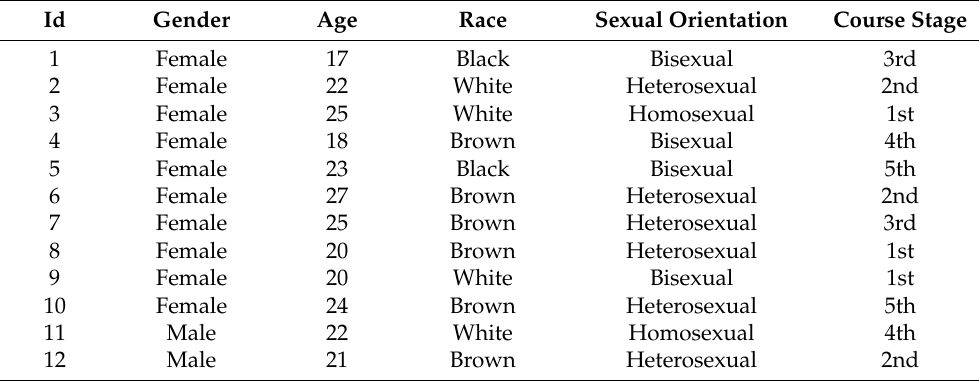
Table 1. Characteristics of the participants.